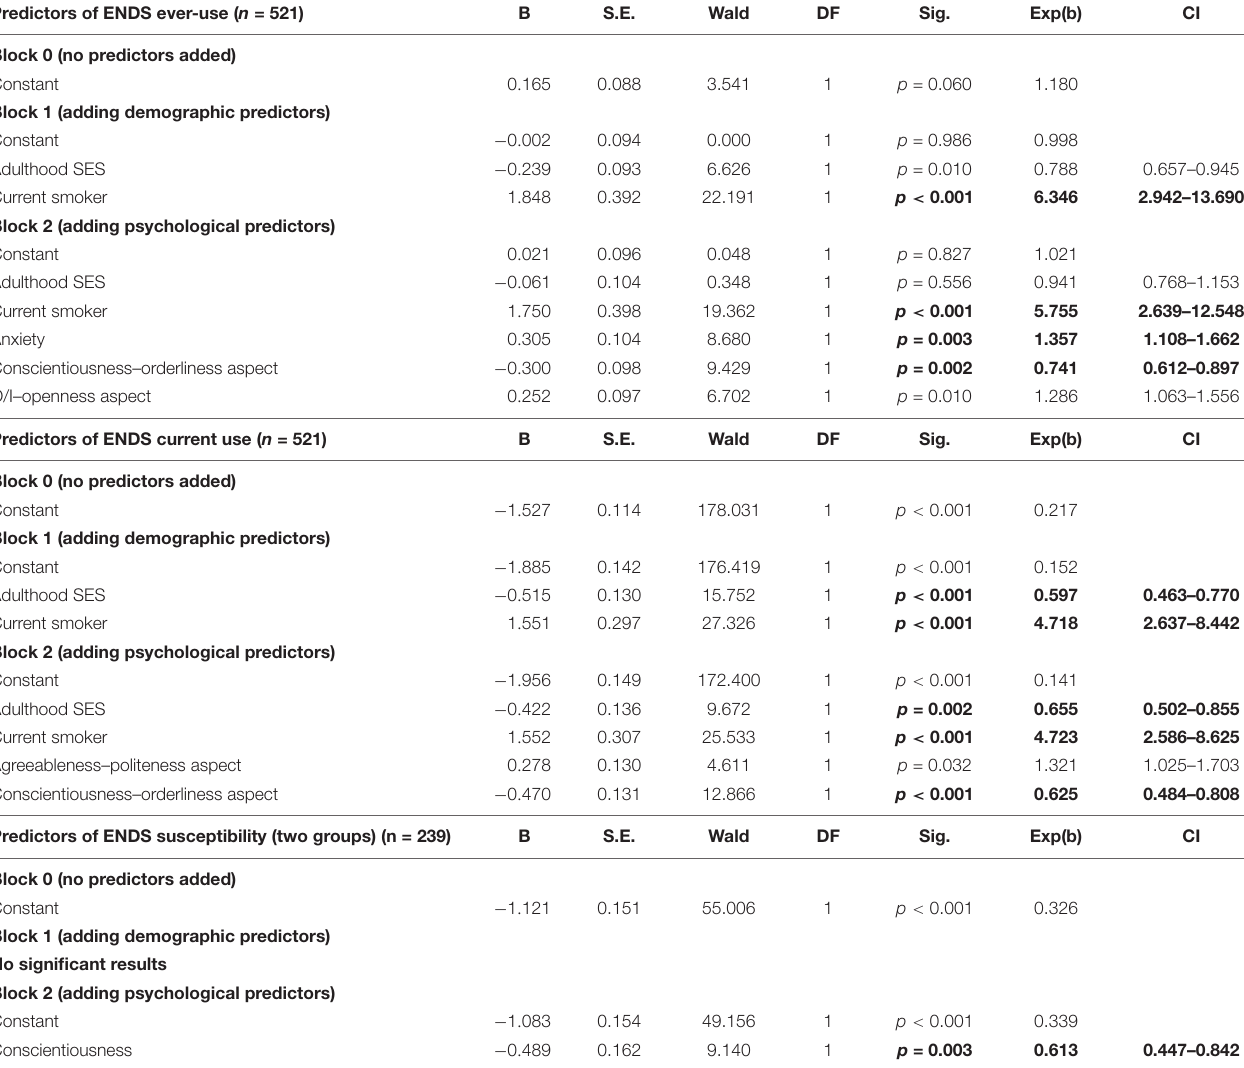
TABLE 4 | Results of the multiple logistic regression showing estimates in odds ratios (confidence intervals) for ENDS ever-use, current use, and susceptibility based on the two groups categorization. Predictors of ENDS ever-use ( n = 521) B